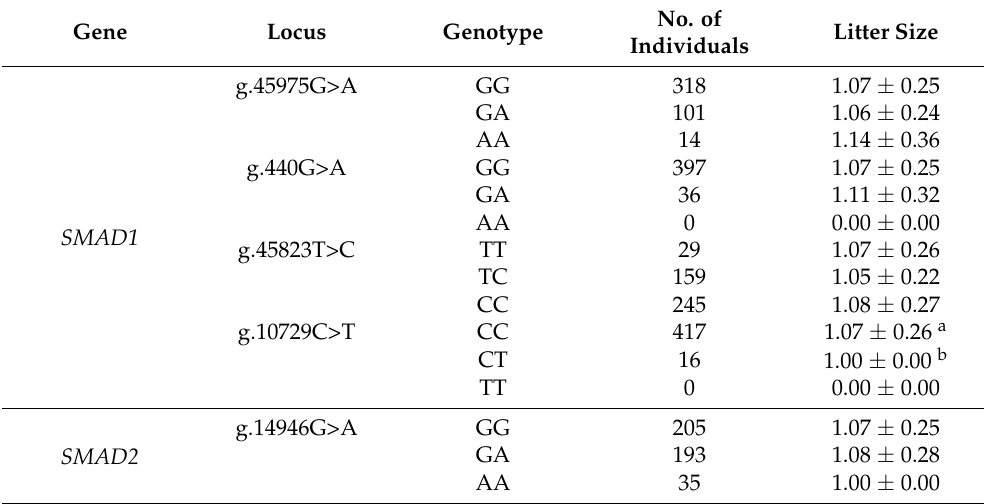
Table 5. Association analysis between SNPs polymorphism of SMAD1 , SAMD2 and SMAD3 genes and litter size in Tibetan